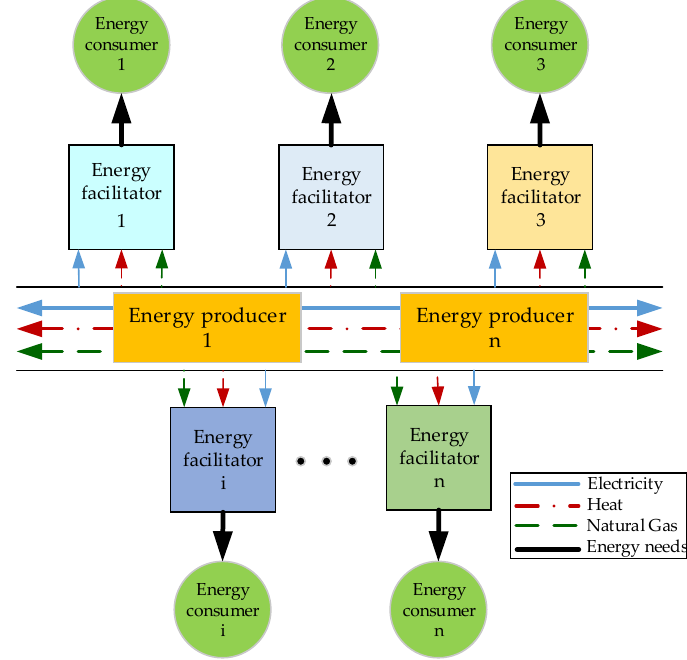
Figure 1. Multi carrier energy system (MECS).